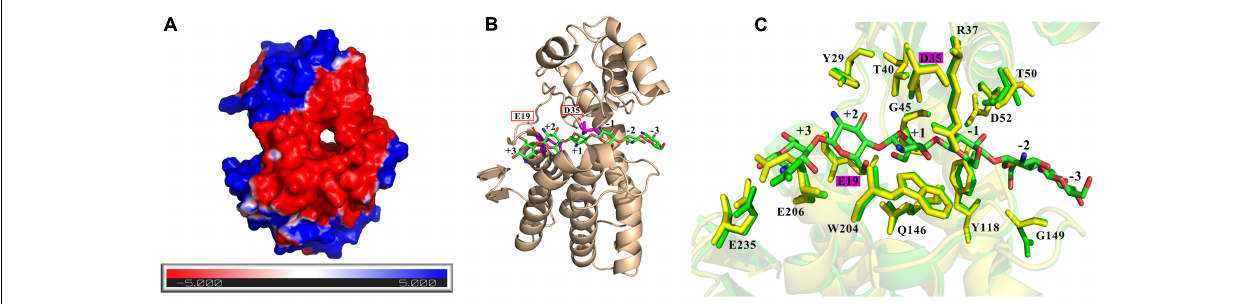
FIGURE 4 | Homology modeling structure and docking of Csn-SH. (A) The electrostatic-potential surface of Csn-SH. (B) The overall structural view of Csn-SH in complex with (GlcN) 6 . (GlcN) 6 was labeled − 4 to + 2 from the nonreducing end to the reducing end. Two catalytic residues (E19 and D35) of Csn-SH were colored by magenta. (C) Substrate interaction of Csn-SH. The residue numbers of Csn-SH represented the sequence without 32 amino acids (signal peptide) at N-terminal. The amino residues from Csn-SH and chitosanase CsnMY002 (PDB: 7C6C) are colored by yellow and green, respectively.